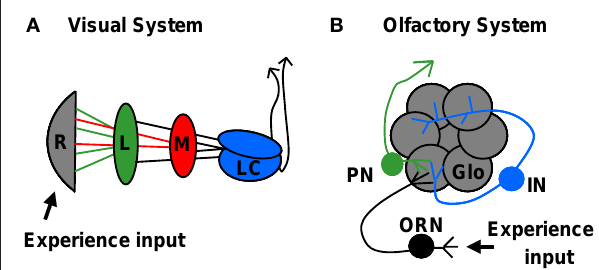
FIGURE 1 | Organization of Drosophila olfactory and visual systems. (A) The visual lobe receives input from retinal photoreceptor cells (grey). Photoreceptors 1–6 project to the lamina neuropil (green) while photoreceptors 7 and 8 project to the medulla neuropil (red). Signals are further processed in the lobula complex (blue) before proceeding to higher order brain regions. (B) The olfactory system receives input from olfactory sensory neurons (black), which each project axons to unique olfactory lobe glomeruli (grey). Local interneurons (blue) process information from multiple glomeruli. Projection neurons (green) transmit signals to higher order brain regions, including the Mushroom